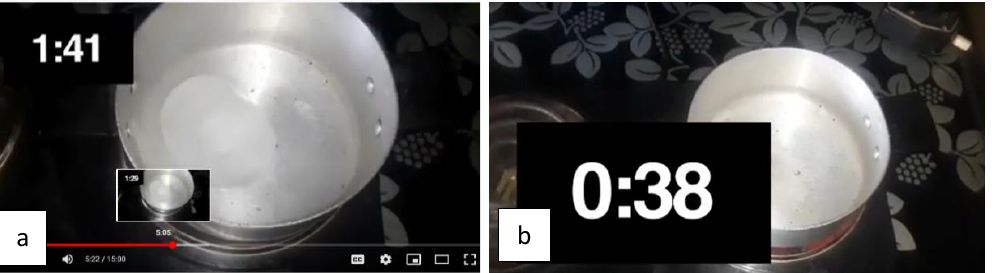
Figure 4. Group 4 experiment: comparing the time needed for frozen and tap water to